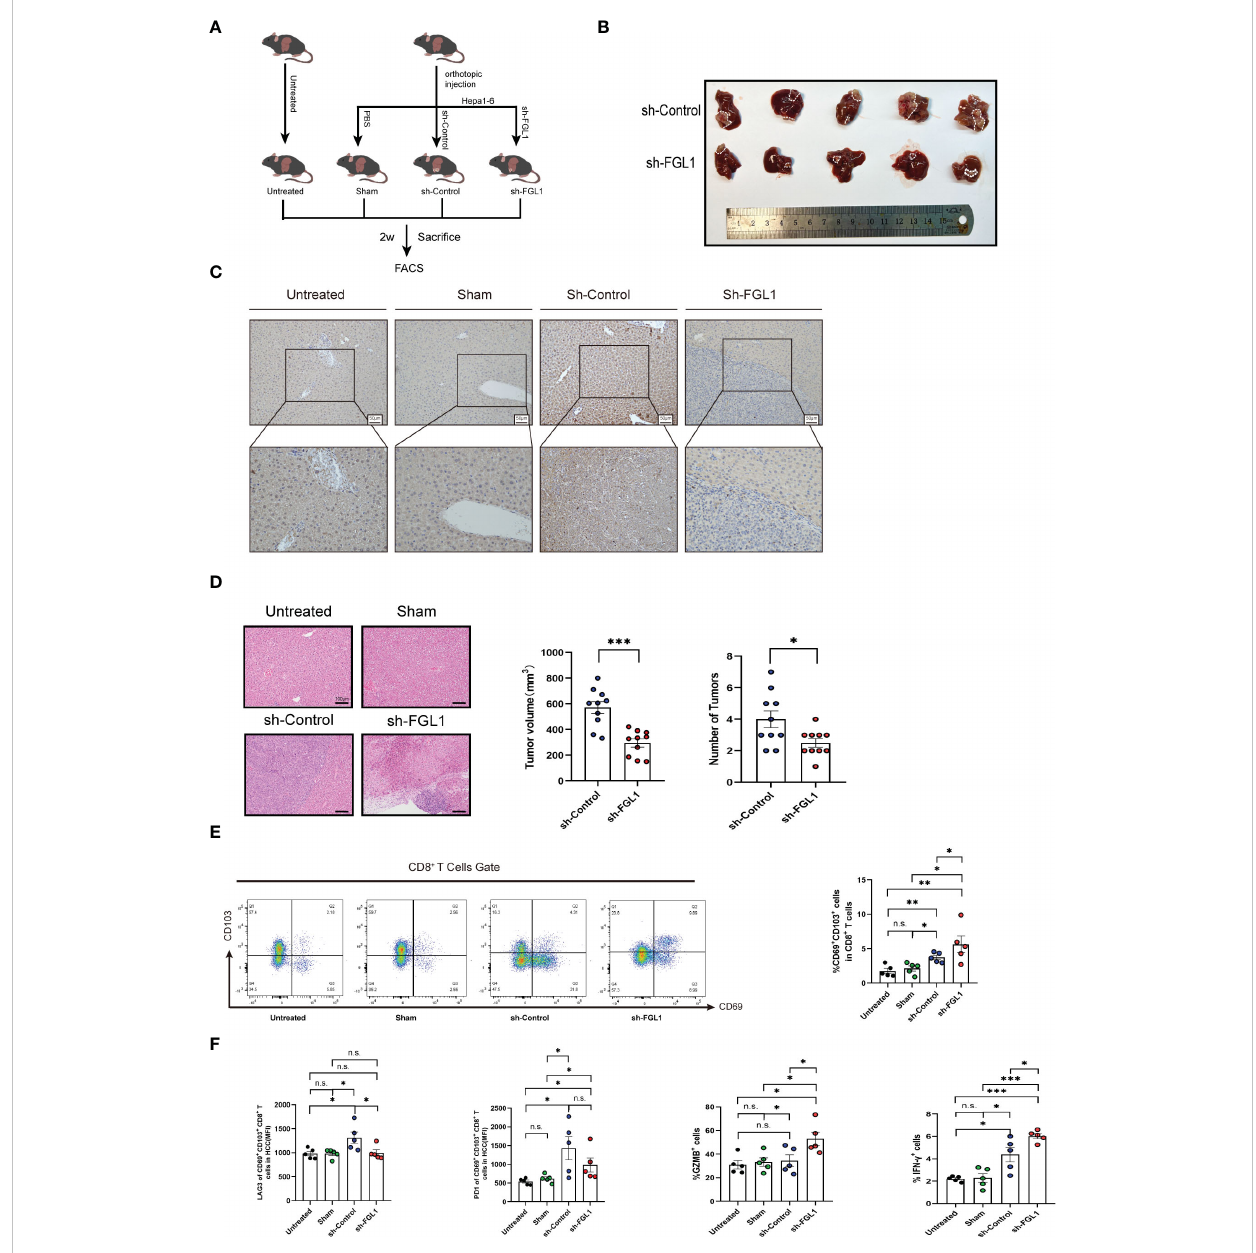
FIGURE 5 Fgl1 knockout restored CD8 + T RM cell functions and inhibited tumor expansion in vivo (A) C57BL/6J mice were classi fi ed into four groups and euthanized 14 days after orthotopic injection with PBS or Hepa1-6 cell line (transferred with sh-Control or sh-Fgl1, n=5). (B) Representative images of the tumors from the sh- Fgl1 and sh-Control groups. (C) Representative IHC staining of FGL1 (inverted microscope, 200×, 400×) in the livers of mice in each group. (D) Representative H&E-stained sections of each group. (E) Percentage of CD8+ T RM cells in each group. (F) Expression of the immune checkpoints PD-1 and LAG3 as well as GZMB and IFN- g in CD8+ T RM cells. (A – F) n >5, a paired t-test. Bars represent mean ± SEM. FGL1, fi brinogen-like protein 1; H-E, hematoxylin-eosin; IHC, immunohistochemistry; sh, short hairpin (RNA). n.s. means not sigini fi cant. *P < 0.05, **P < 0.01, ***P <